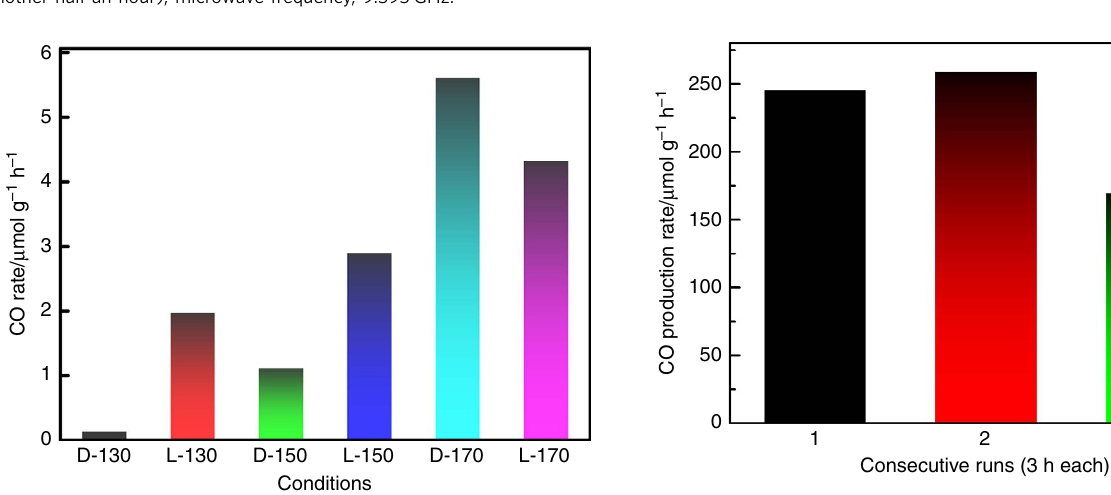
Figure 4 | EPR studies. EPR spectra of ncSi:H samples ( a ) in N 2 (red, at room temperature; pink, at 170 (cid:2) C in dark; blue, at 170 (cid:2) C with 0.5 sun); microwave frequency, 9.393GHz, ( b ) in CO 2 (red, at room temperature; pink, at 170 (cid:2) C in dark for over half an hour; blue, at 170 (cid:2) C with 0.5 sun for another half an hour); microwave frequency, 9.393GHz.